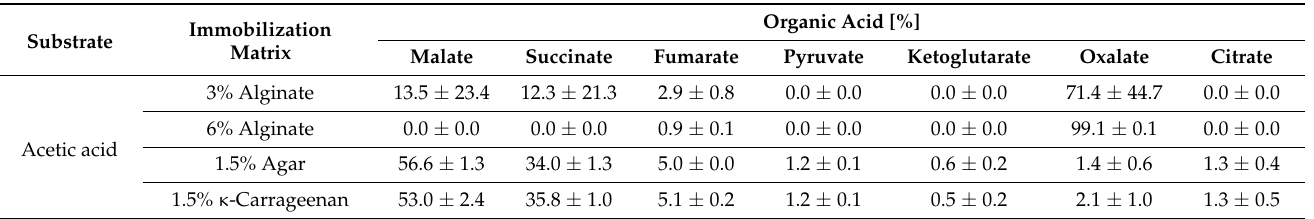
Table A3. Acid distribution for shake flask cultivations of A. oryzae after 144 h using acetate as carbon source in main culture, while preculture was grown without carbon source. Values are means of triplicates with standard